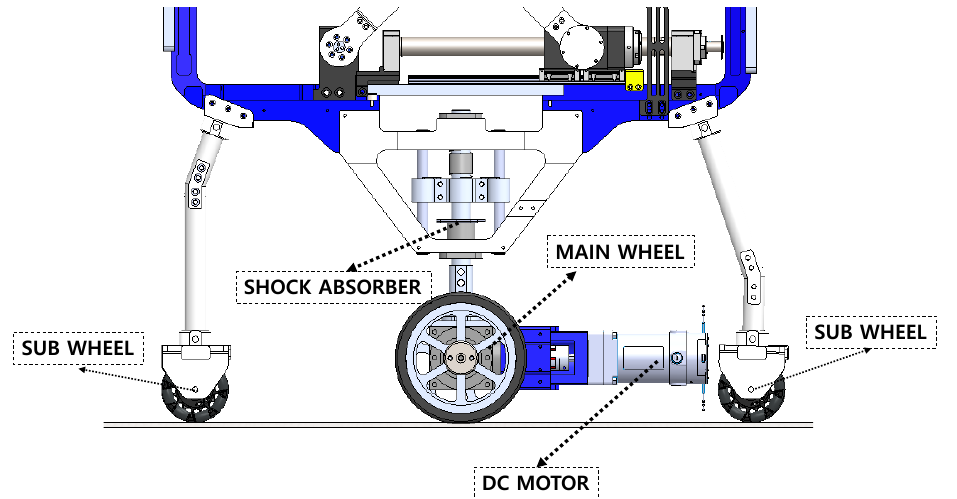
Figure 8. Detailed design of the mobility part. The front and back sides of the robot have sub-wheels. The sub-wheels were of the omni-wheel type. Omni-wheels can allow a system to move in all directions (e.g., rotation). Omni-wheels do not have an actuator. The objective of the sub-wheel is direction guidance and to avoid disturbing the main wheel drive. The main wheel is located at the middle of the robot. The main wheel comprises a DC motor that generates the driving force to realize the mobility of the robot and patients. The mobility part also comprises a shock absorber. This part allows the robot to travel over various terrains during overground gait